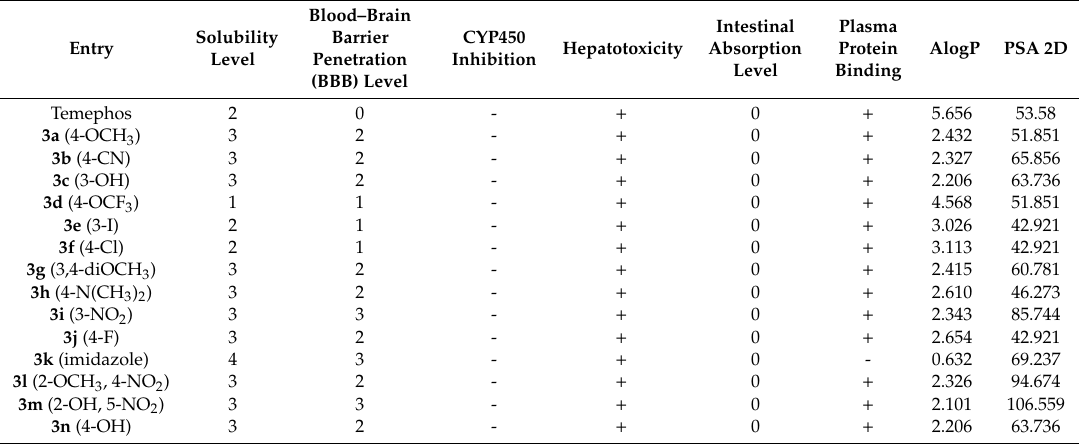
Table 5. In silico ADMET properties of quinazolines ( 3a–n) and